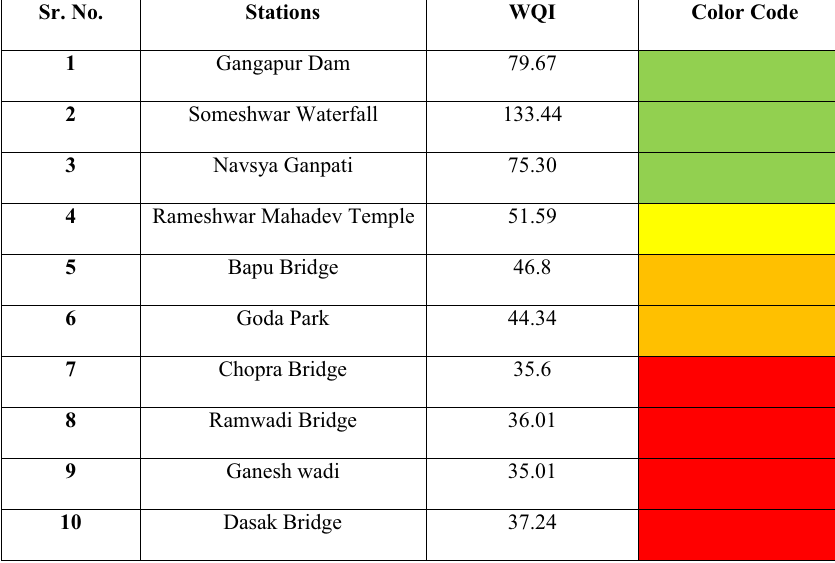
sampling sites of Godavari river